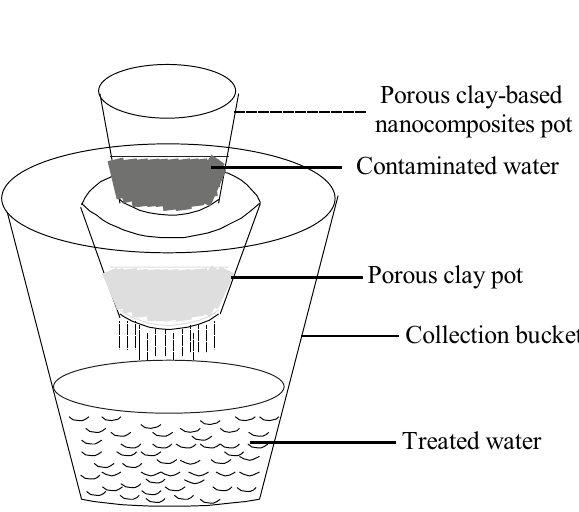
Fig. 20 The mini-scale nanocomposite filtration